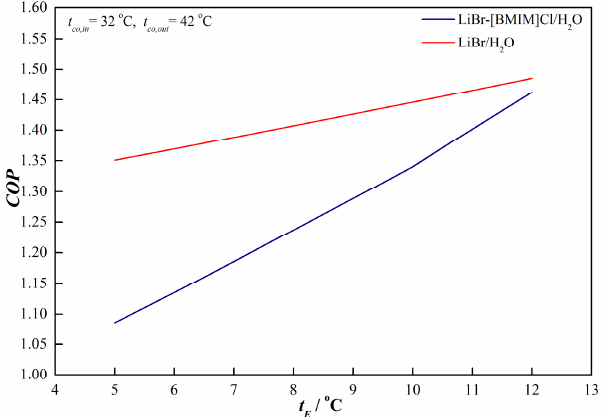
Figure 10. Variations of coefficient of performance ( COP ) with the evaporation temperature t E .